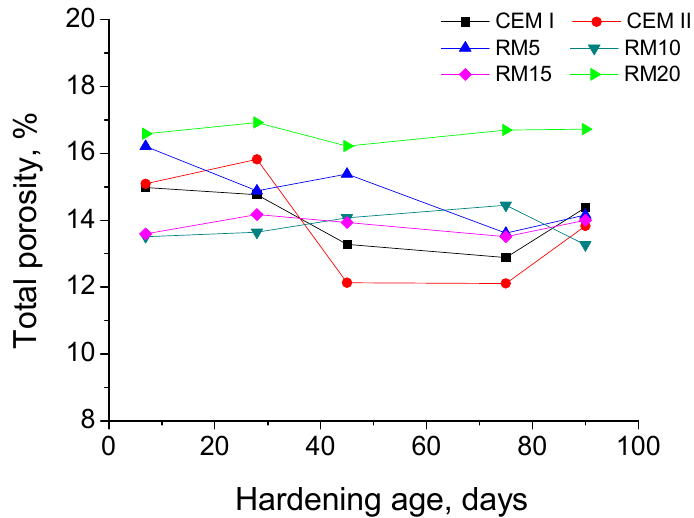
Figure 3. Results of total porosity for mortars prepared with contents of 5% (RM5), 10% (RM10), 15% (RM15) and 20% (RM20) of red mud, compared to those obtained for ordinary Portland cement (CEM I) and Portland cement with fly ash (CEM II) mortars.